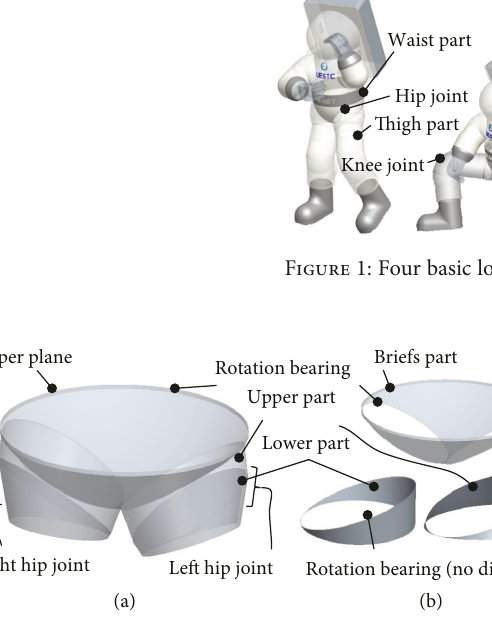
Figure 2: Conceptual models of the (a) hip joint and (b) its